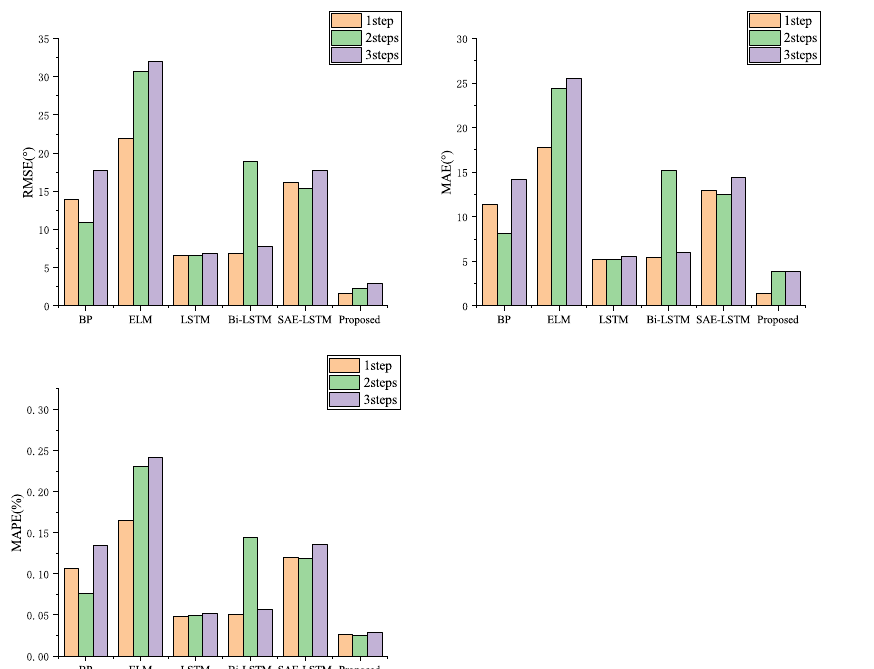
Figure 16. Roll angle prediction error distribution of Dataset 1.